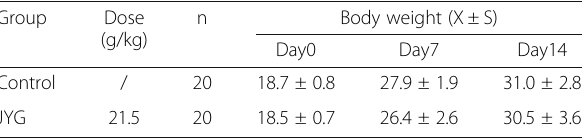
Table 2 Body weight in the control and JYG-treated group in the acute toxicity test